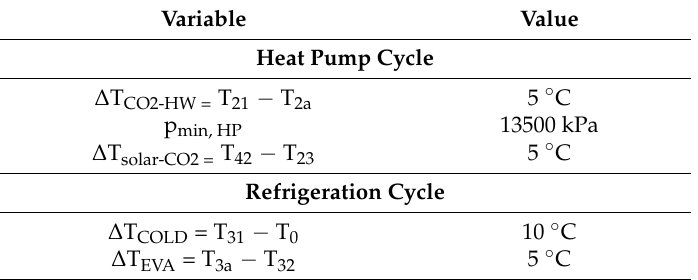
Table 1. Reference design parameters for the Heat Pump and Refrigeration